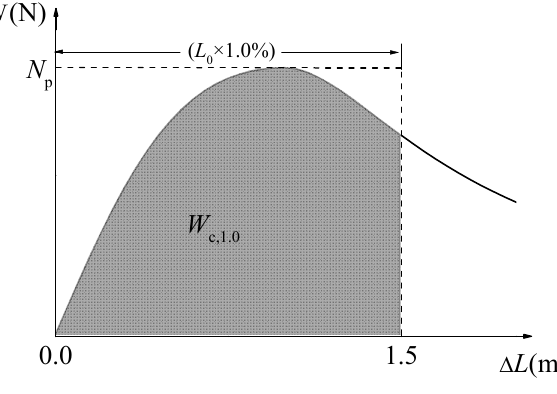
Figure 13. Calculation diagram for R e,1.0 .